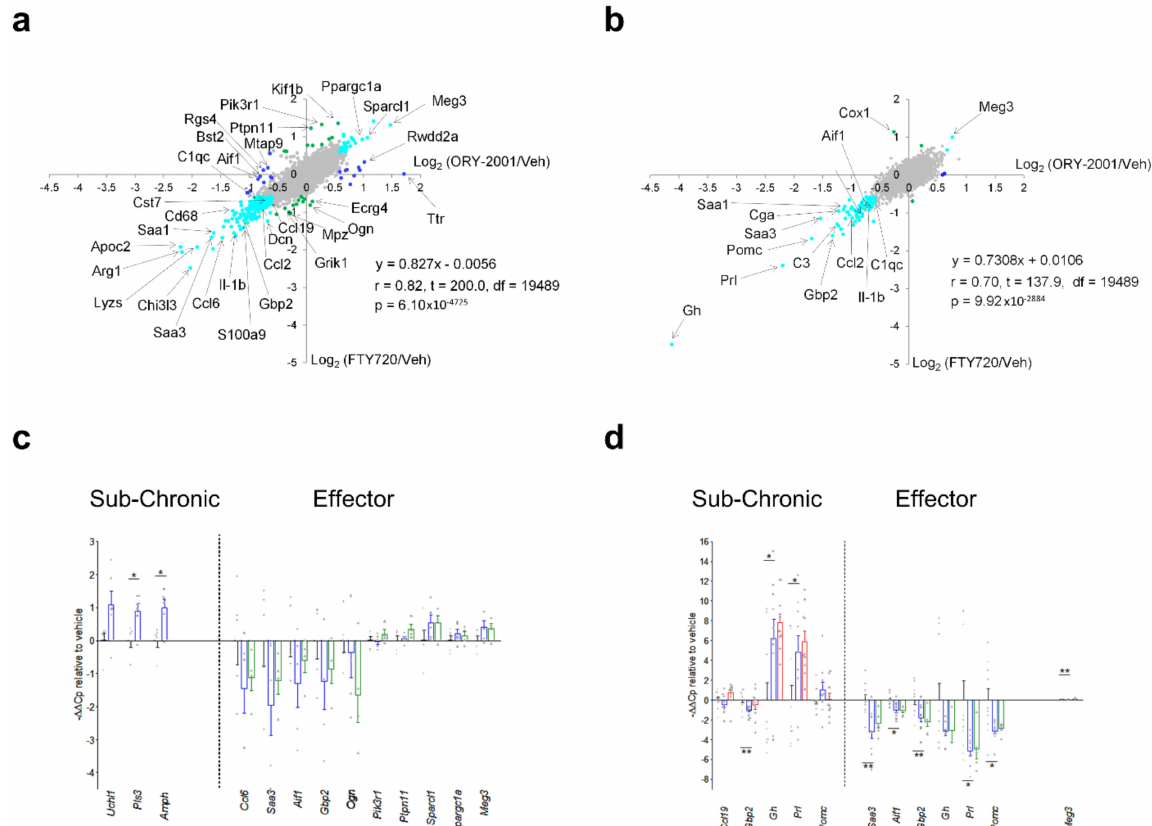
Figure 9. Comparisons of gene expression changes induced by ORY-2001, FTY720, and ORY-LSD1. Genome wide comparisons of expression changes induced by ORY-2001 and FTY720 in the spinal cord ( a ) or the brain ( b ) at the effector phase. Data are represented as scatterplots of Log 2 (ORY-2001/Veh) versus the Log 2 (FTY720/Veh) values. Genes regulated > 0.6-fold are represented in blue if they are specific to ORY-2001, in green if they are specific to FTY720, or in cyan if they are regulated in the same direction by ORY-2001 and FTY720. Microarray surveys were performed on pooled samples: ( a ) N = 5 mice/group (vehicle, ORY-2001), N = 4 (FTY720); ( b ) N = 10 mice/group (vehicle, ORY- 2001), N = 6 (FTY720), and each datapoint was generated from a triplicate on array-measurement. Linear regression analysis calculated on 19,491 data points ( a , b ). r = Pearson correlation coefficient, t = t-Student test t value, df = degrees of freedom, p = probability of the two-tailed t-distribution for t and df. qRT-PCR validations of selected individual genes modulated by ORY-2001 (blue), ORY-LSD1 (red) and FTY720 (green) in the effector phase or sub-chronic phase in ( c ) spinal cord and ( d ) brain. Data are represented as − ∆∆ Cp values relative to vehicle and as mean ± SEM. In ( c ), samples for sub-chronic phase: N = 5 mice/group (vehicle), N = 6 mice/group (ORY-2001); effector phase: N = 5 mice/group (vehicle, ORY-2001), N = 4 mice/group (FTY720). In ( d ) samples for sub-chronic phase: n = 10 mice/group (vehicle, ORY-2001, ORY-LSD1); effector phase: n = 10 mice/group (vehicle, ORY-2001), N = 6 mice/group (FTY720). ( c , d ) For each mouse sample, the average of three technical replicate PCRs was calculated and is shown as a grey dot. Statistical analysis between vehicle and ORY-2001 was calculated using the two-tailed unpaired t -test. Welch’s correction was applied when the populations had unequal variances. * p < 0.05, ** p <